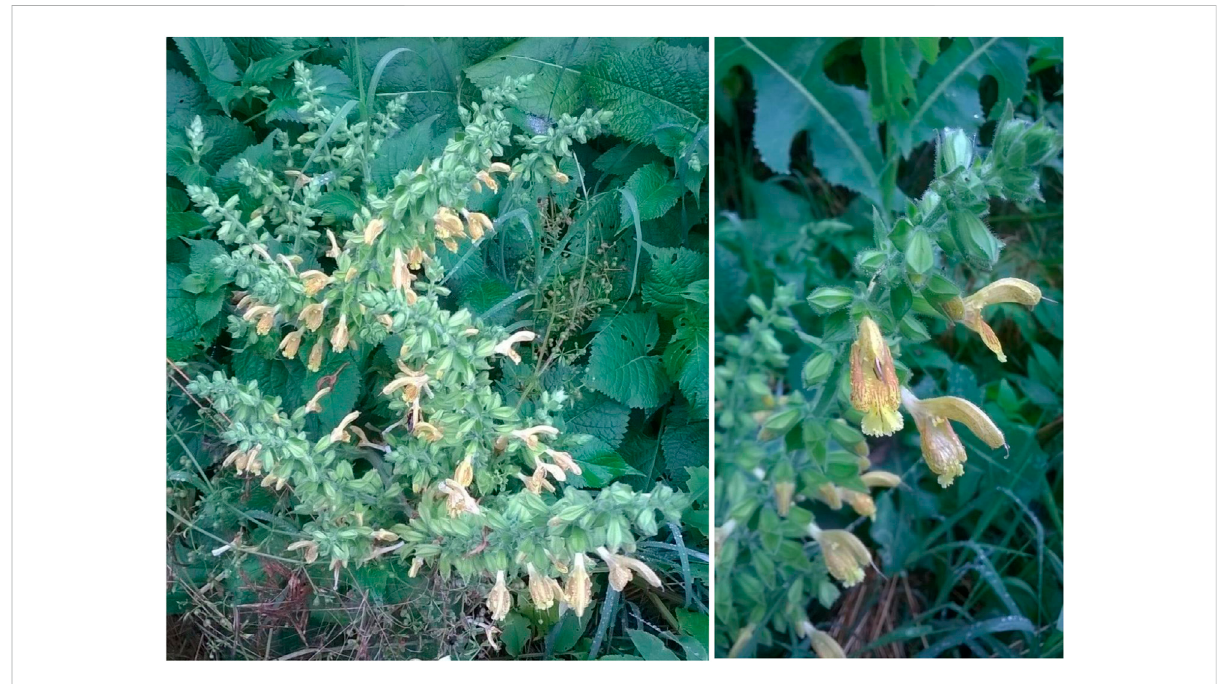
FIGURE 1 Appearance of S. glutinosa aerial parts, which have been used for